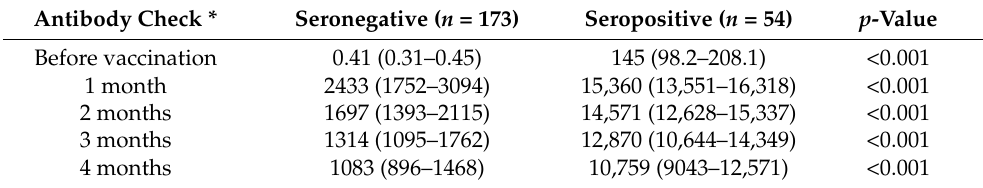
Table 3. Comparison of spike antibodies in seronegative vs. seropositive pregnant patients.